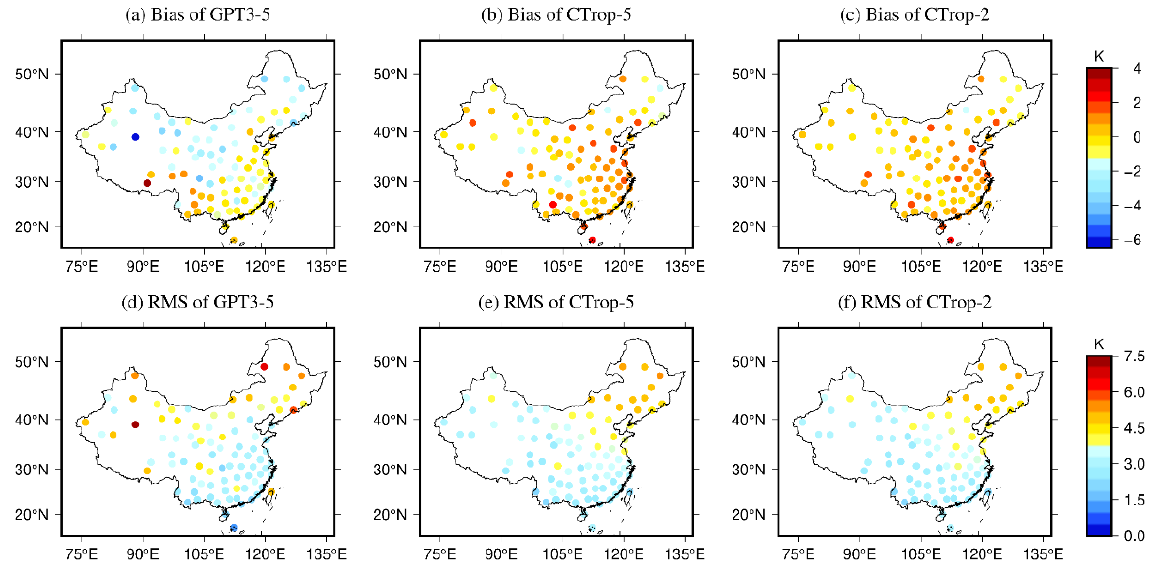
Figure 12. Distribution of the performance of pressure in different resolutions of the CTrop and GPT3 models validated by radiosonde sites in 2017: ( a ) Bias of GPT3-5; ( b ) Bias of CTrop-5; ( c ) Bias of CTrop-2; ( d ) RMS of GPT3-5; ( e ) RMS of CTrop-5; ( f ) RMS of CTrop-2.